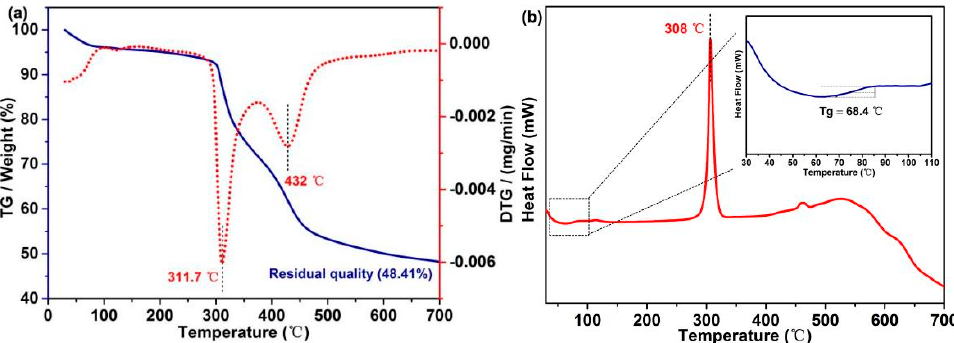
Figure 5. ( a ) TG and DTG curves and ( b ) DSC curves of PFs.